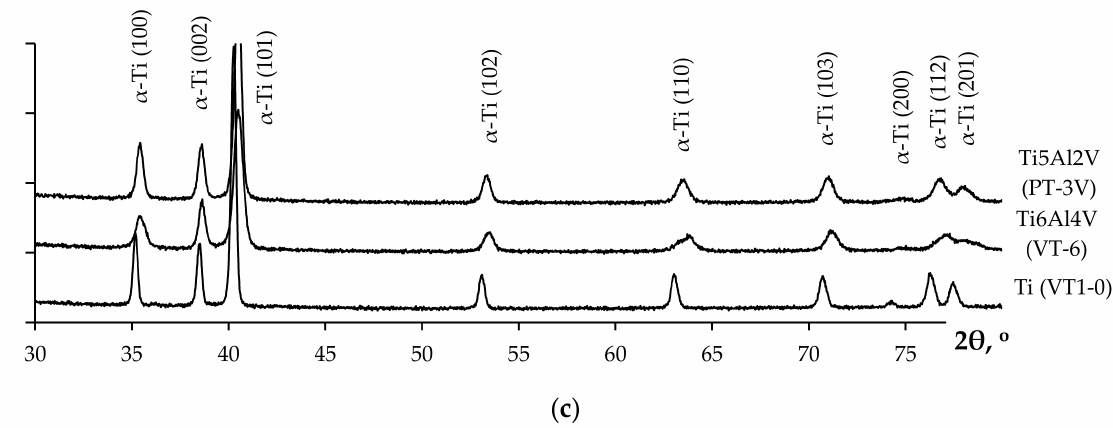
Figure 1. SEM images (BEC mode) of Ti5Al2V powder ( a , b ) and XRD spectra ( c ) of initial powders.